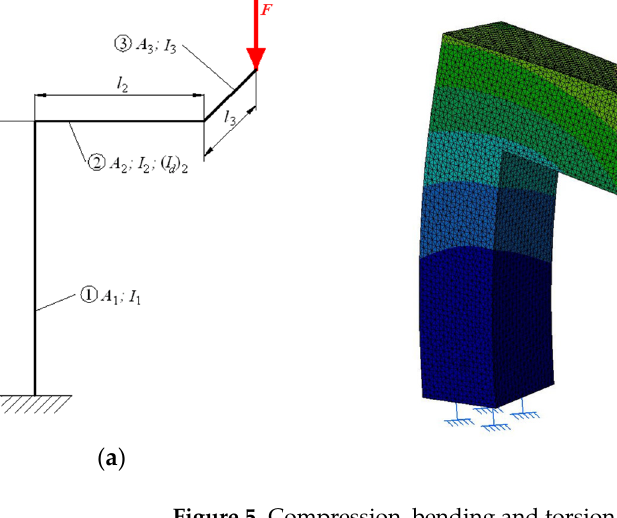
Figure 5. Compression, bending and torsion deformation of a pole with double arm in the console. Schematic representation ( a ) and state of deformations ( b ).